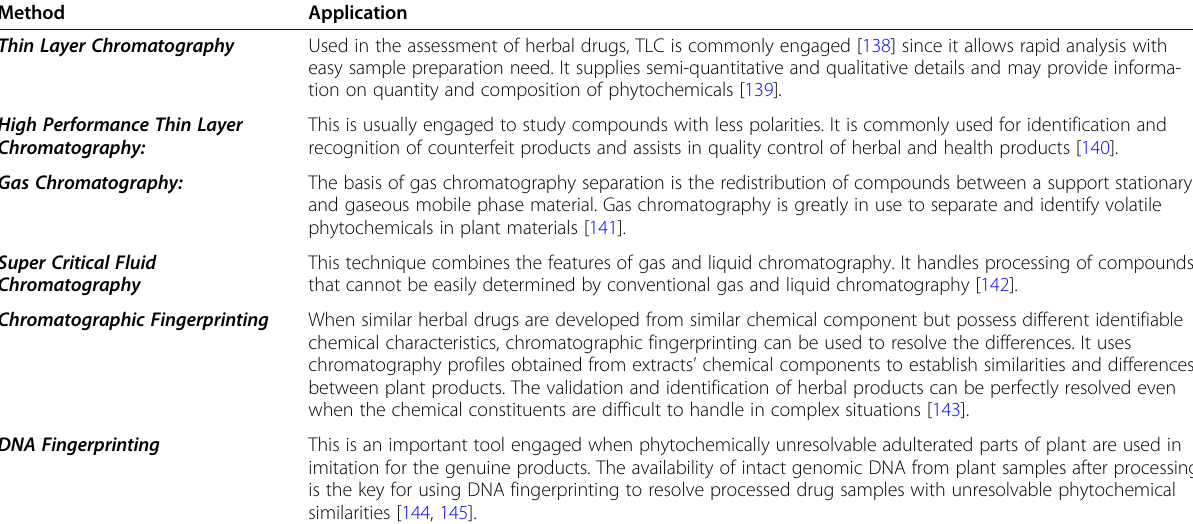
Table 4 Various techniques for herbal drug analysis